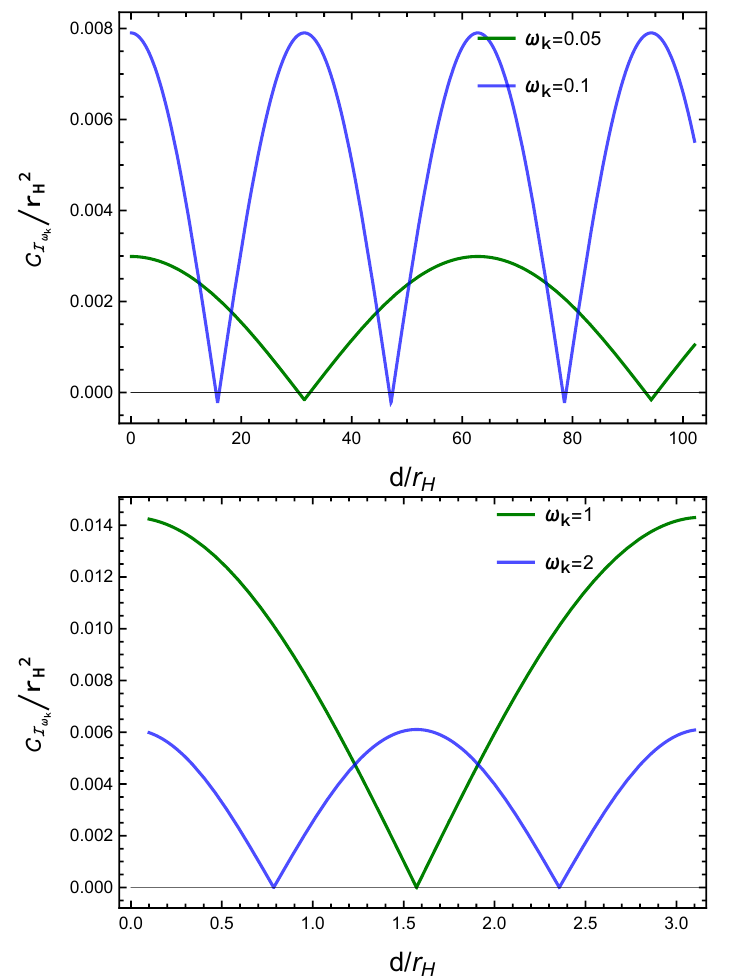
is plotted for two outgoing null detectors in different parallel Figure 8 . The quantity C I /r 2 H ωk paths in a (1 + 1) dimensional Schwarzschild black hole spacetime with respect to the separation = 0 . 05 and between the two paths d/r . The dimensionless frequency of the field are fixed at ω H k ω k = 0 . 1 , respectively in the upper plot and shows entanglement shadow regions. Whereas in the lower plot, the dimensionless frequency of the field are fixed at ω = 1 and ω = 2 , respectively and k k shows entanglement shadow points instead of the shadow regions.The detector transition energy is fixed at ∆ E = 0 . 5